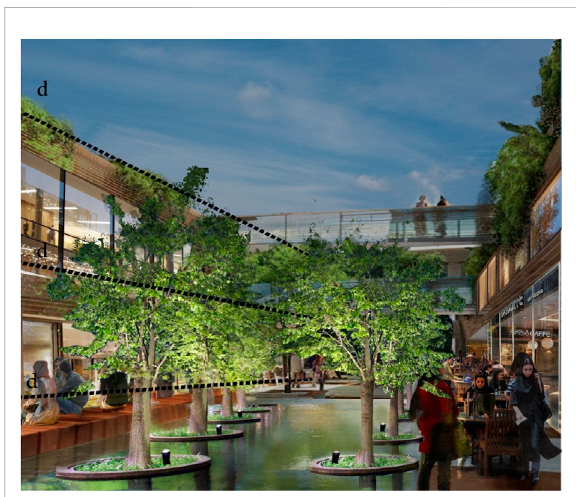
FIGURE 4 Photo on Card two shows Attribute “ water ” with “ pond ” level, attribute “ plant ” with “ vertical ” level, attribute “ orientation ” with “ horizontal ” level, and attribute “ shape ” with “ straight ” level, attribute “ solid/void ” with “ no void ” level, attribute “ material ” with “ transparent ” level, and attribute “ dimension (height) ” with “ medium ”